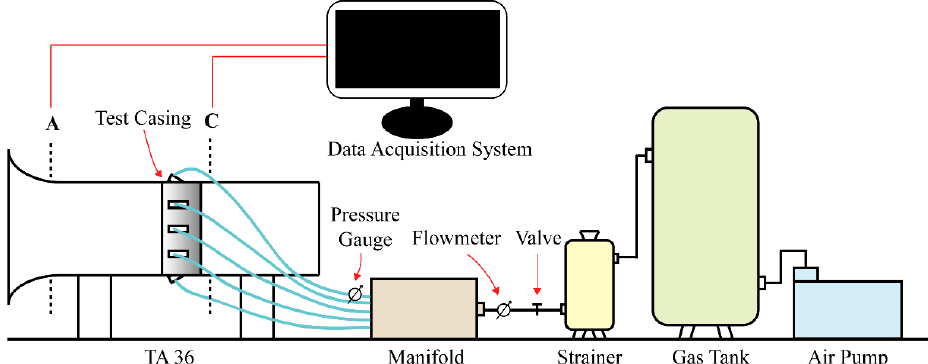
Figure 6. The oscillator–compressor experimental system.